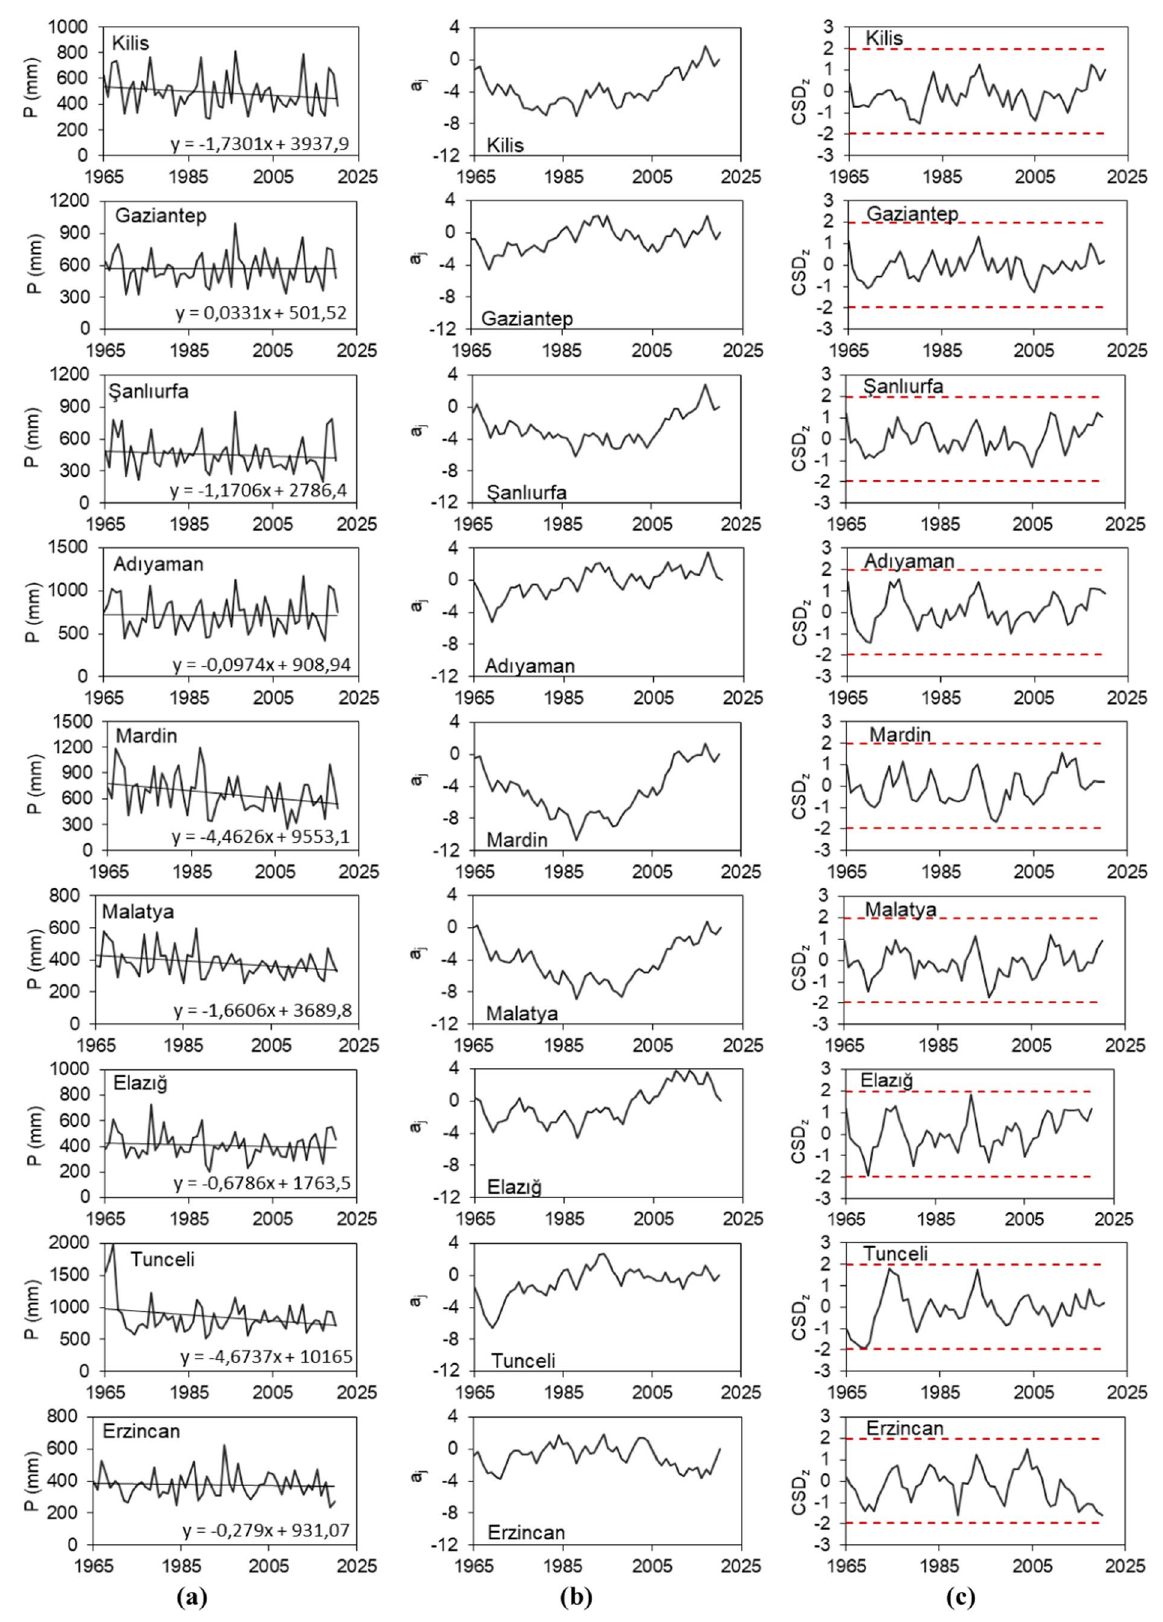
Fig. 7 a Precipitation time, b aj and c CSDz series for the